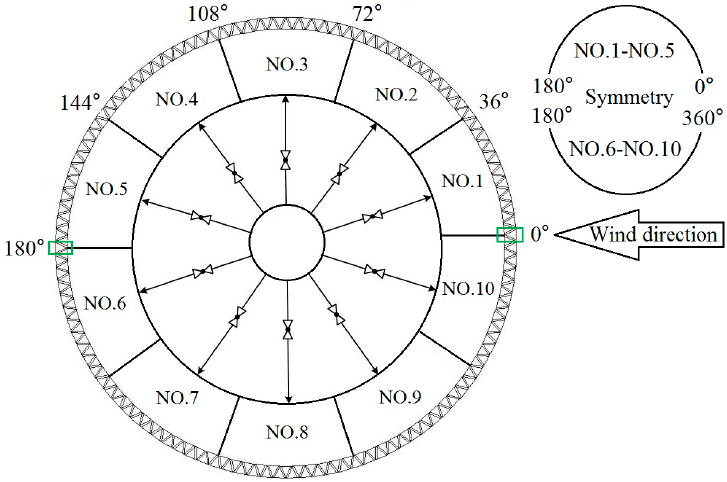
Figure 2. Air-cooled sectors specification for the circulating water distribution along wind direction.